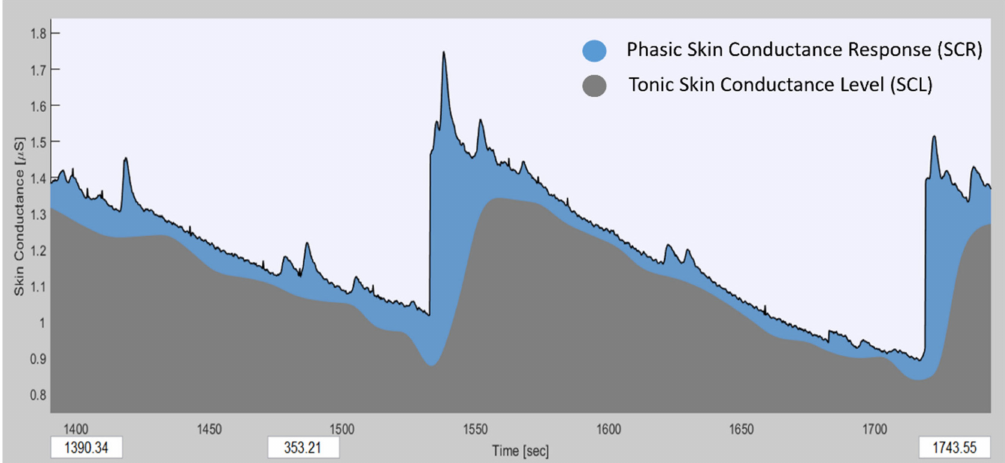
Figure 6. Phasic and tonic components of EDA